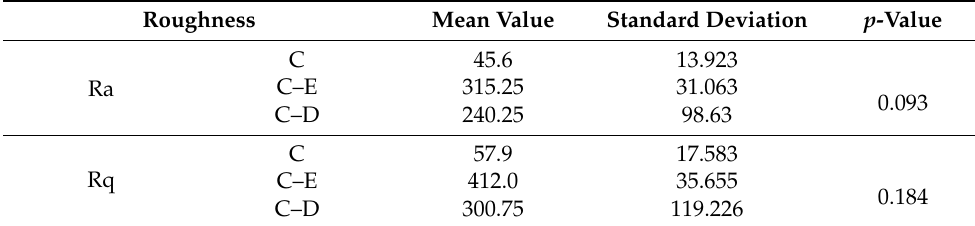
Table 2. Roughness values for the Group A